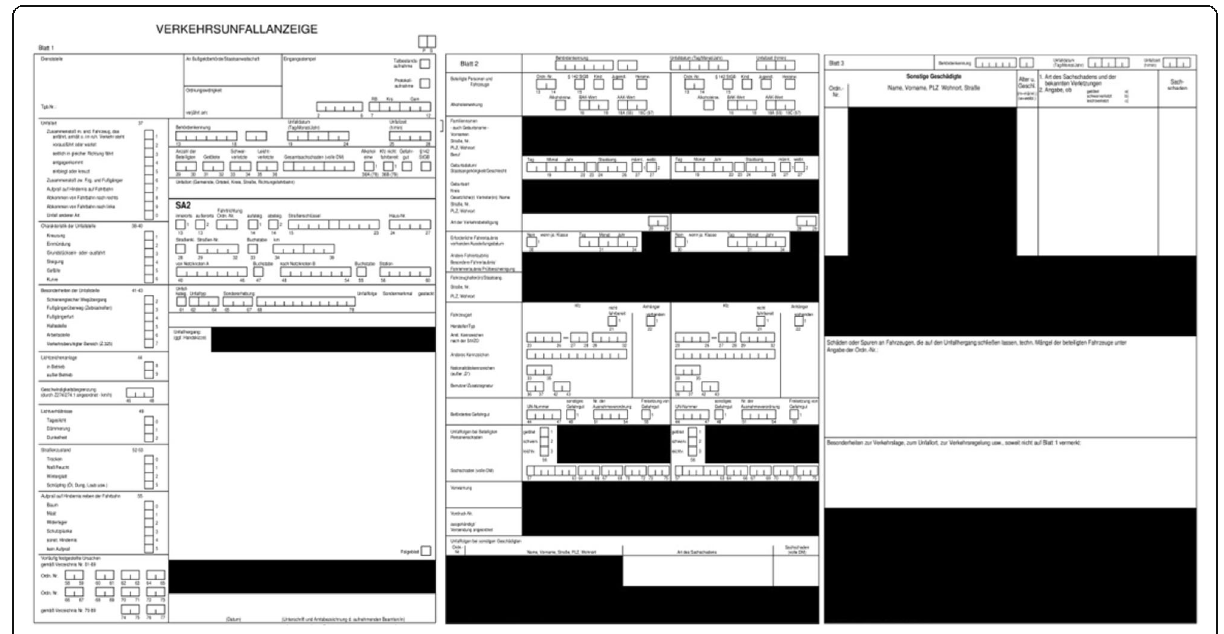
Fig. 5 Form for a police road accident